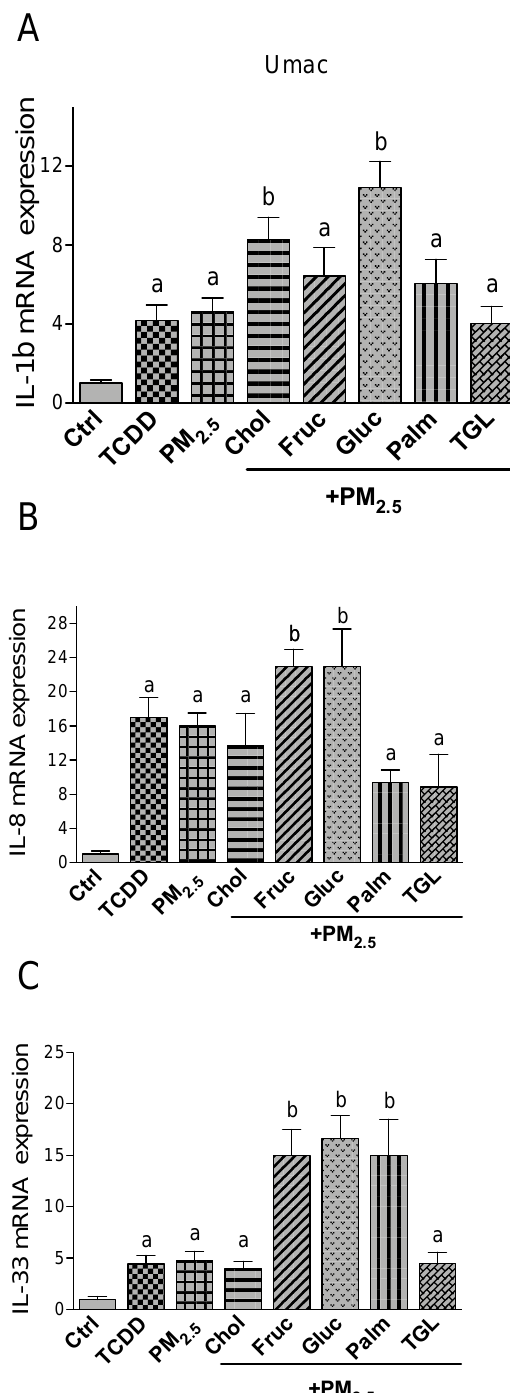
Figure 2. E ff ect of nutritional compounds on PM 2.5 -induced cytokine expression in Umac. Cells were treated with 1 nM TCDD and 10 µ g / mL PM 2.5 for 24 h. The e ff ect of nutritional factors cholesterol (Chol, 10 µ g / mL), fructose (Fruc, 25 mM), glucose (Gluc, 25 mM), palmitic acid (Palm, 5 µ M), and triglyceride (TGL, 10 µ g / mL) was tested in presence of PM 2.5 after 24 h treatment. Control cells were treated with the corresponding vehicle. The mRNA expression of ( A ) IL-1 β ; ( B ) IL-8, and ( C ) IL-33 was analyzed by qPCR. The expression was corrected against the housekeeping gene ß-actin. a significantly higher than Ctrl; b significantly higher than cells treated with PM 2.5 only p < 0.05.